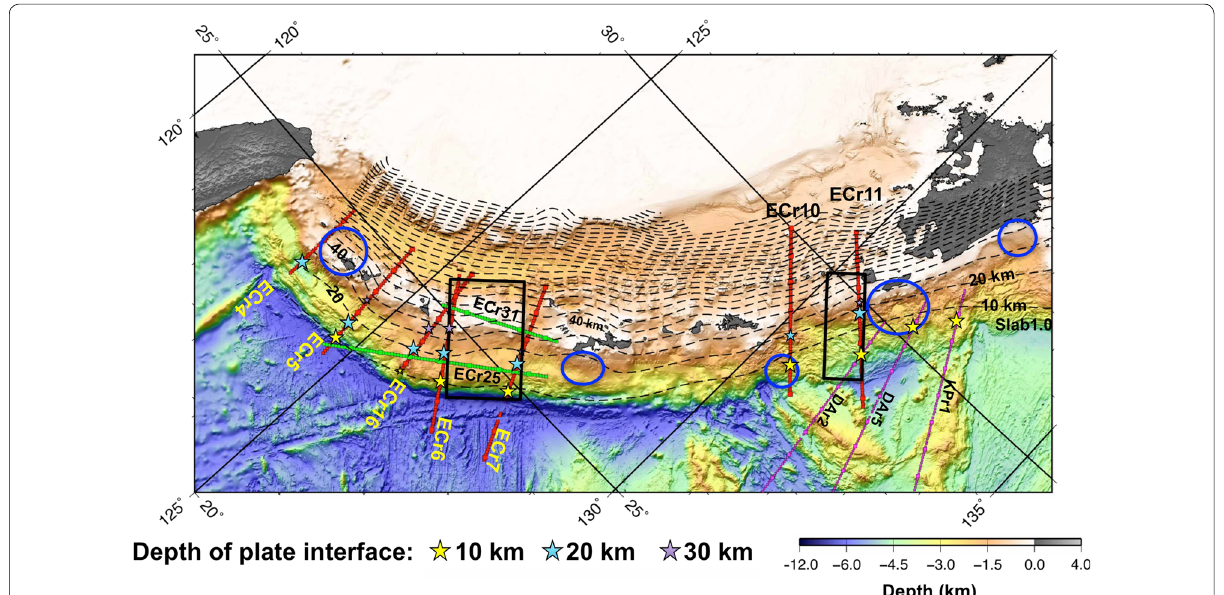
Fig. 10 Depth of the Philippine Sea plate interface ( asterisks ) obtained in this study. Small asterisks indicate lower accuracy. Broken lines present iso-depth contours of the plate interface with an interval of 10 km (Hayes et al. 2012). Blue circles and black rectangles show several clusters of short- term slow slip events and the area of poor resolution, respectively (Nishimura